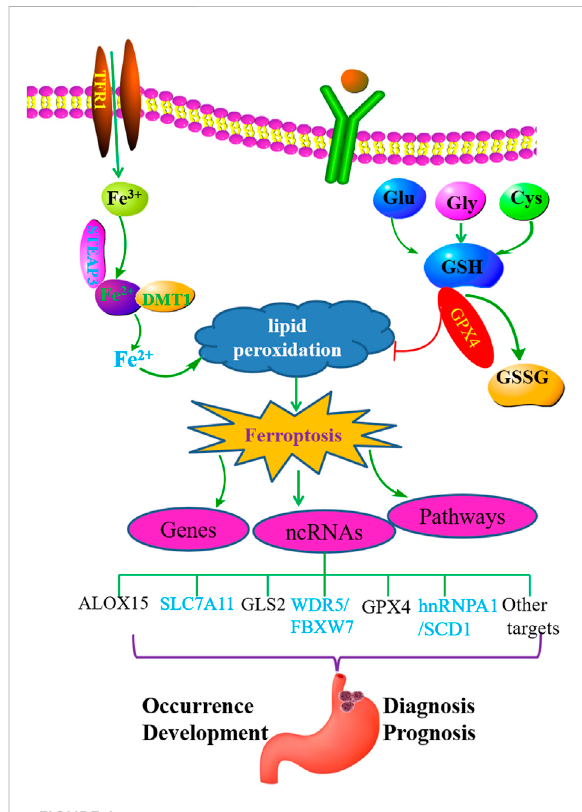
FIGURE 1 Ferroptosis plays an important role in GC and may regulate the occurrence and development of gastric cancer by interacting with related